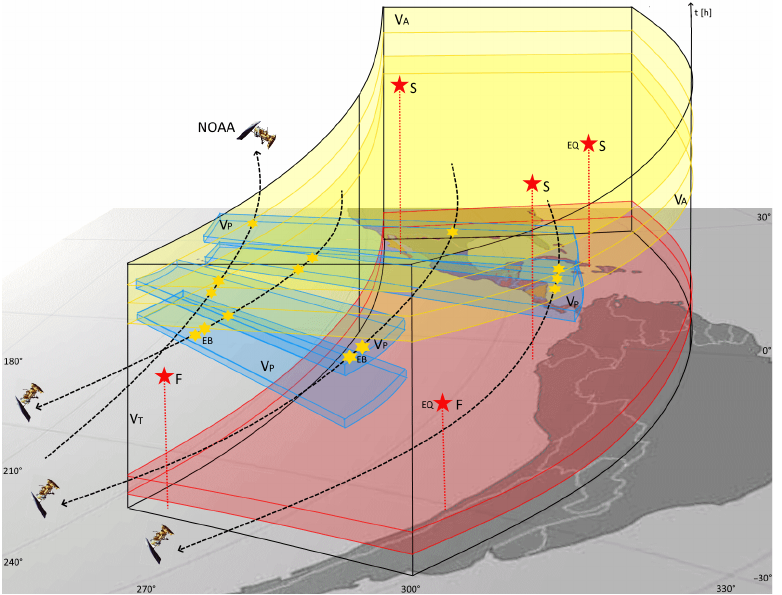
Figure 8. The scenario is the volume representation where a forecasting model can be tested, here it is delimited by the target volume V T , the alert volume V A , and the precursor volume V P , the latter two being products among the geographical coordinates of EQs and EBs and the time of observations. Discontinuities in time are due to the solar activity intermittence. The alarm duration can be chosen to be 4 h in this work which corresponds to the greatest significance. V T and V A cover the entire East Pacific area, while V P is restricted to two latitudinal areas being more extended on the west. In red is the possible precursor volume which hypothesizes a physical action on the ionosphere of the future epicenter lithosphere.